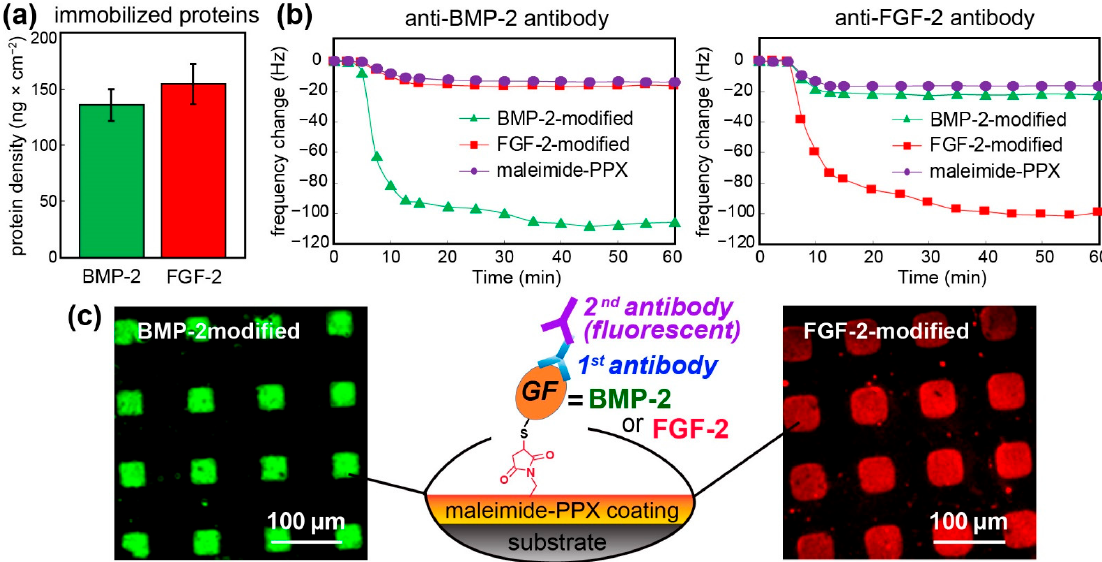
Figure 2. ( a ) Quantification of the conjugation densities of BMP-2 and FGF-2 by using QCM analysis. ( b ) QCM dynamic analysis of the binding affinity of the studied surfaces toward anti-BMP-2 and anti-FGF-2 antibodies. ( c ) The activity and specificity of the immobilized growth factors were verified by exploiting a μ CP technique to spatially confine the conjugation of BMP-2 and FGF-2 to defined locations. Combinations of self-assembled binding affinities by first antibodies (anti-BMP-2 and anti-FGF-2) and by secondary antibodies (fluorescently labeled secondary antibodies) show that the fluorescence patterns are consistent with the μ CP patterns.